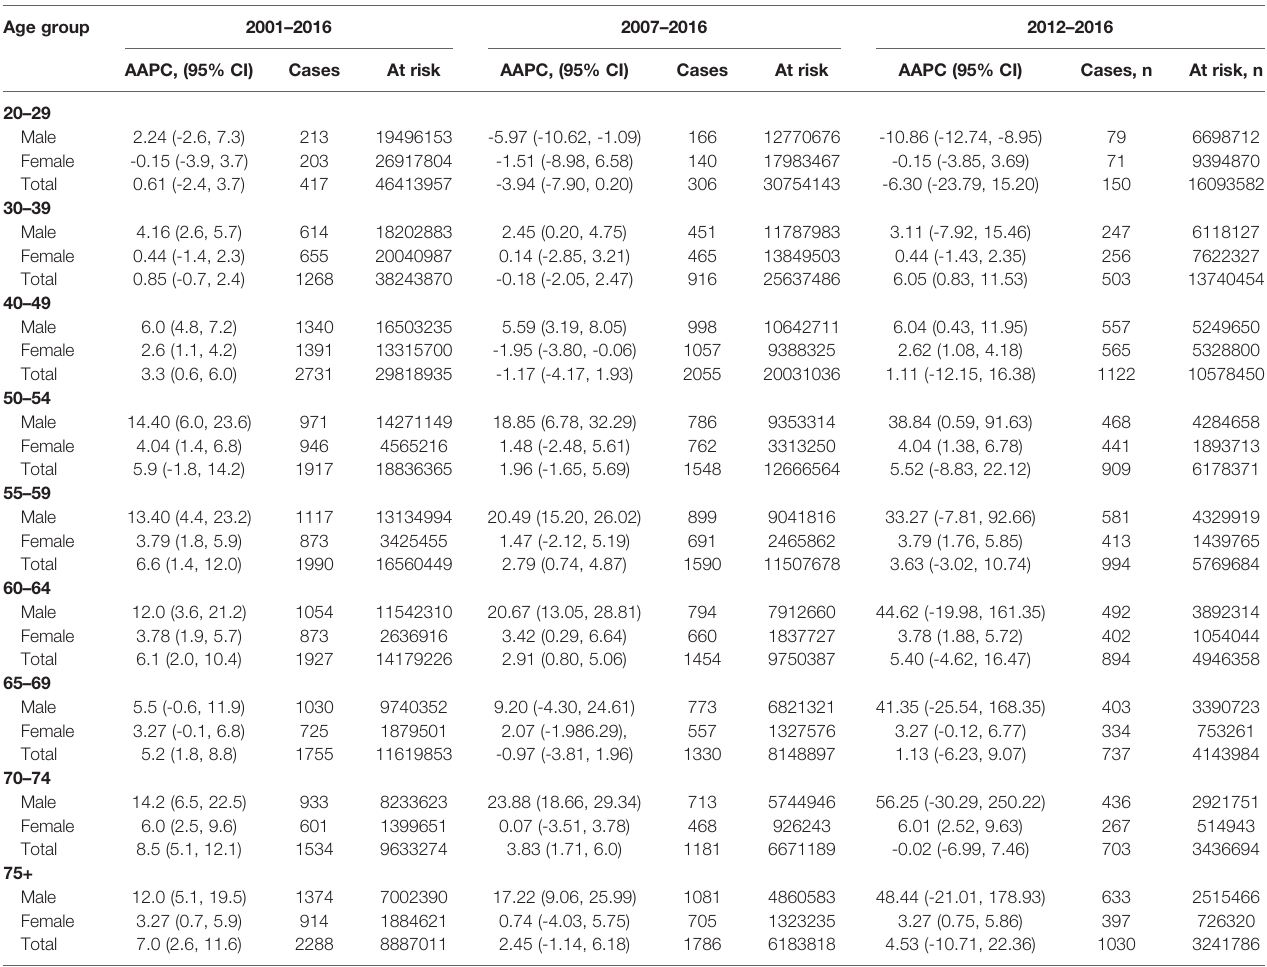
TABLE 5 | The average annual percentage change in colorectal cancer incidence rates, number of cases, and population at risk of colorectal cancer by gender and age, Saudi Arabia, 2001 –